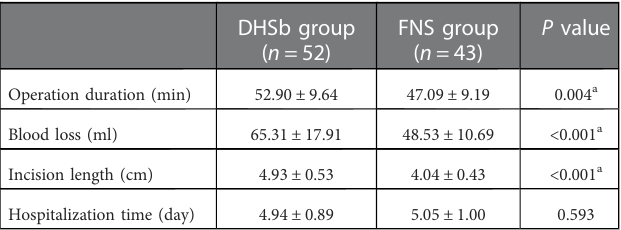
TABLE 2 Operation information of both groups.